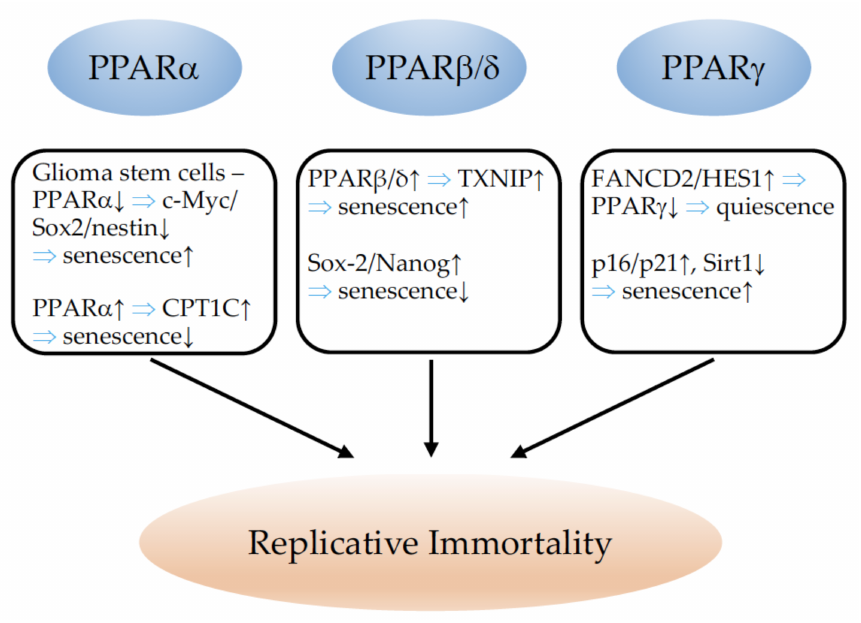
Figure 6. Summary of the effects of PPAR α , PPAR β / δ , and PPAR γ on senescence and replicative immortality. ↓ indicates inhibition and ↑ indicates an increase. ⇒ : leads to; c-Myc: MYC proto- oncogene; Sox2: SRY (sex-determining region Y)-box 2; CPT1C: carnitine palmitoyltransferase 1C; TXNIP: thioredoxin-interacting protein; FANCD2: Fanconi anemia, complementation group D2; HES1: hes family bHLH transcription factor 1; Sirt1: sirtuin